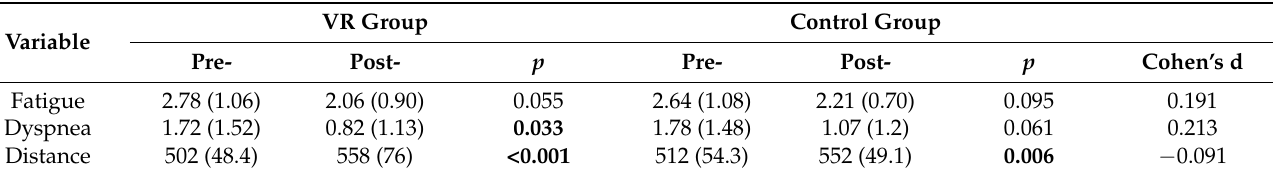
Table 4. Analysis of the functional capacity.